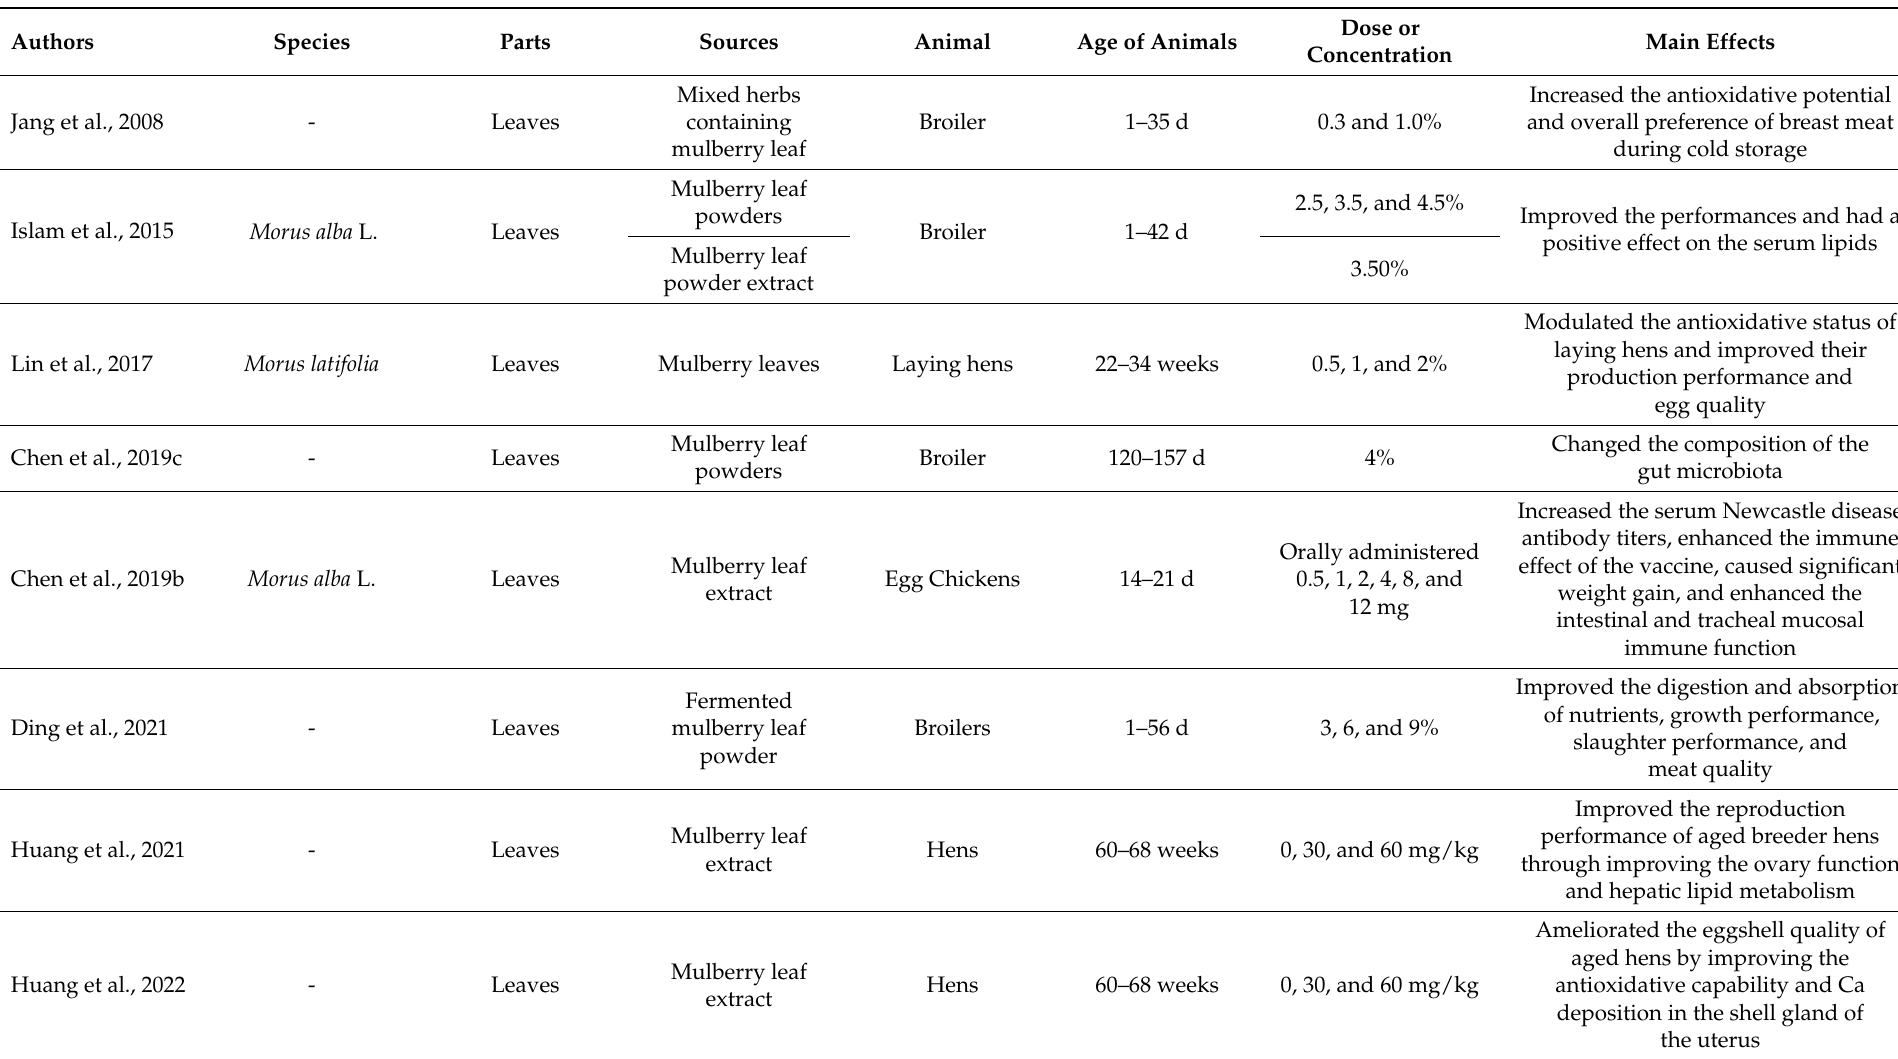
Table 3. The application of mulberry tree extracts on